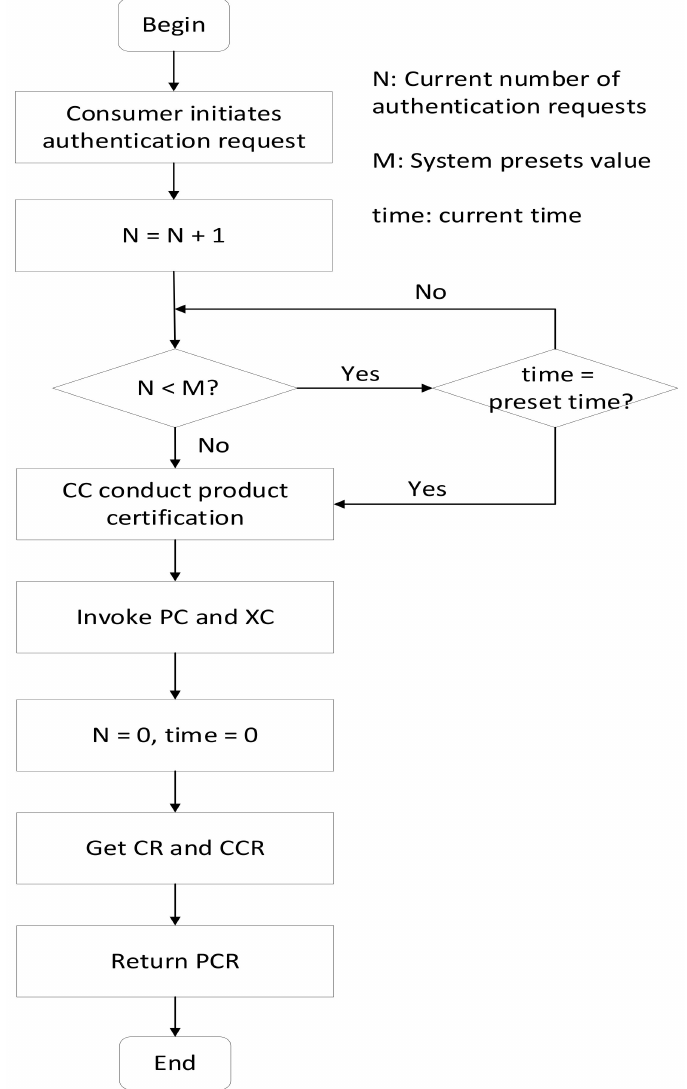
Figure 6. Authentication system